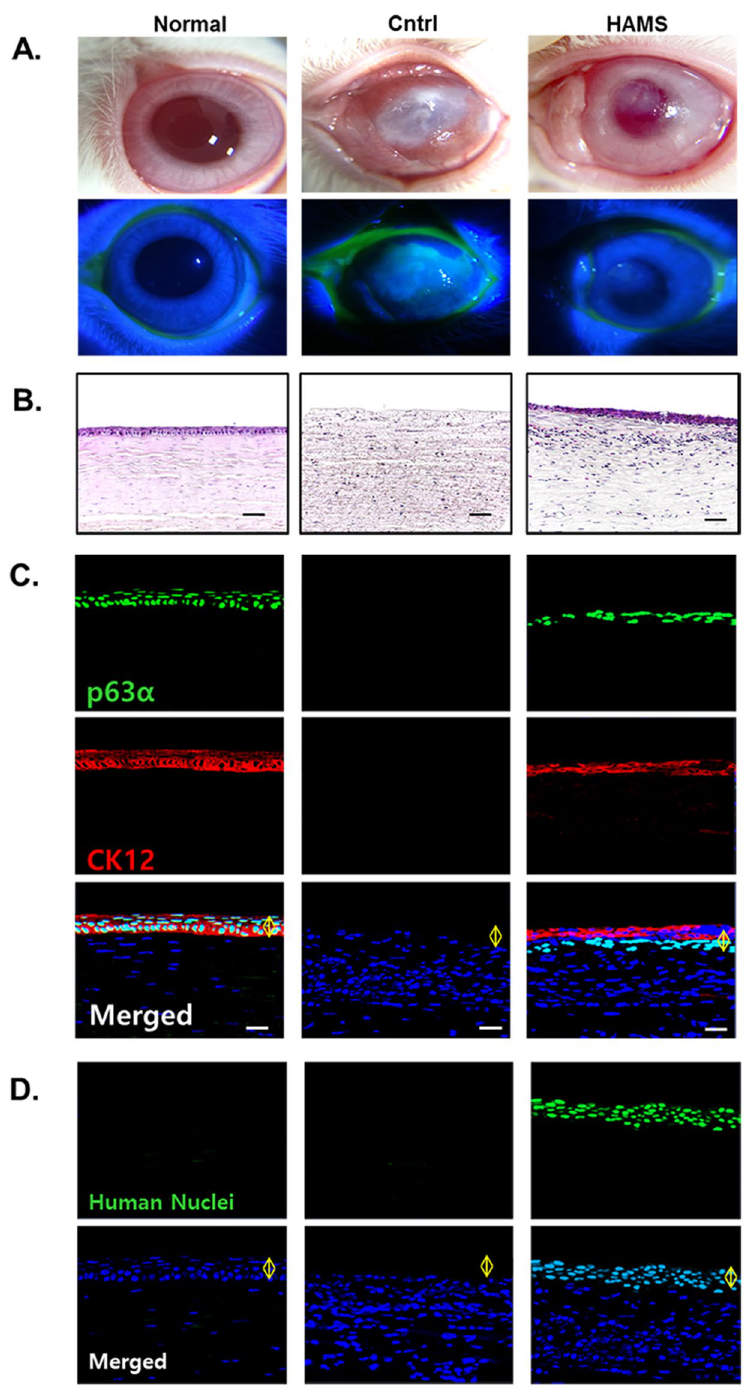
Figure 5. Results of transplantation of human limbal explant outgrowth sheets on HAMS into rabbit LSCD models. ( A ) Microscopic photos of rabbit ocular surface at 4 weeks after transplantation of limbal explant outgrowth sheets onto HAMS. ( B ) Hematoxylin-eosin stained photos of rabbit corneas at 4 weeks after transplantation. Bar = 50 µ m. ( C ) Immunohistochemical examination of rabbit corneas for p63 α and CK12 at 4 weeks after transplantation. Bar = 20 µ m. ( D ) Immunohistochemical examination for human nuclei. Bar = 20 µ m. Normal; healthy rabbit cornea, Cntrl: corneas of LSCD models without transplantation, HAMS: corneas of LSCD models with transplantation of humal limbal outgrowth sheets on